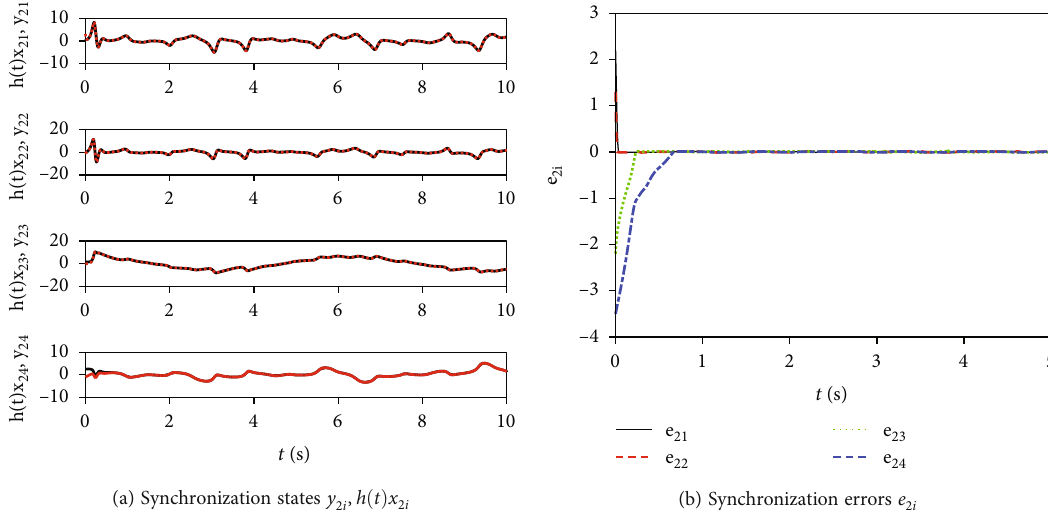
Figure 9: The time evolution of synchronization between y